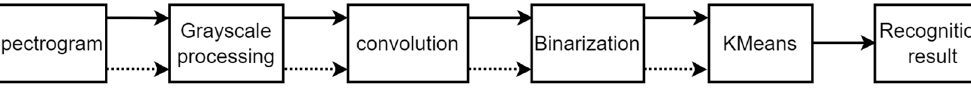
Figure 2. Recognition algorithm (solid line is training flow; dotted line is testing flow).